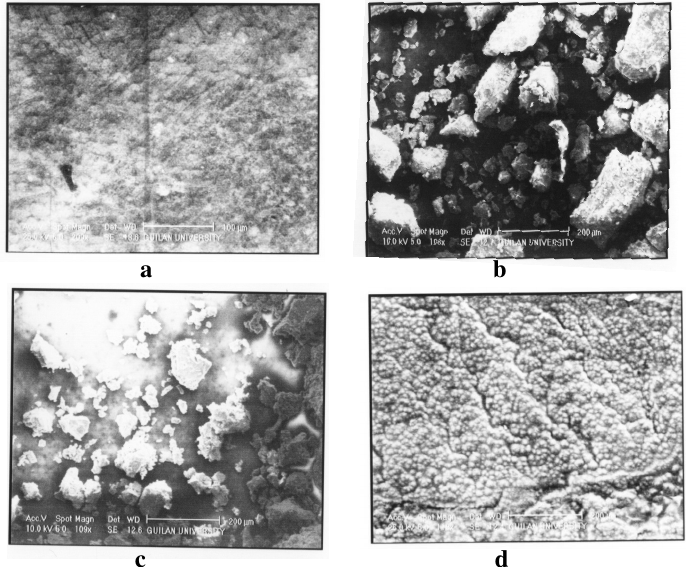
Figure 3. Scanning electron micrographs (SEM) of ( a ) EB/Ny6, ( b ) EB powder, ( c ) PAn/HCl powder, ( d ) EB/Ny6, HCl 0.2 M was used for doping of the polymer.